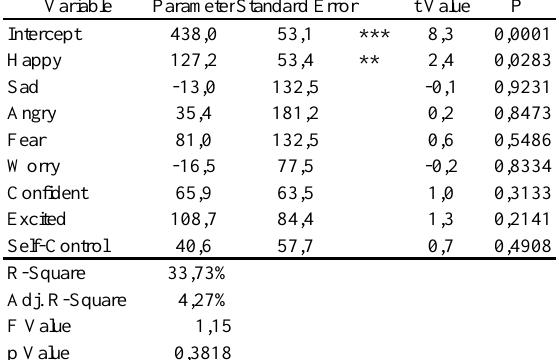
Table 5: Regression of Investor's Total Profit on Emotional State Variable